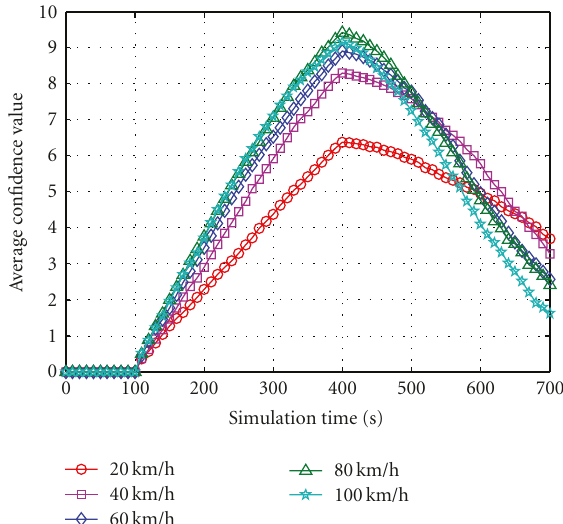
Figure 5: Average accumulation speed of event confidence value to vehicles under di ff erent vehicle mobilities.